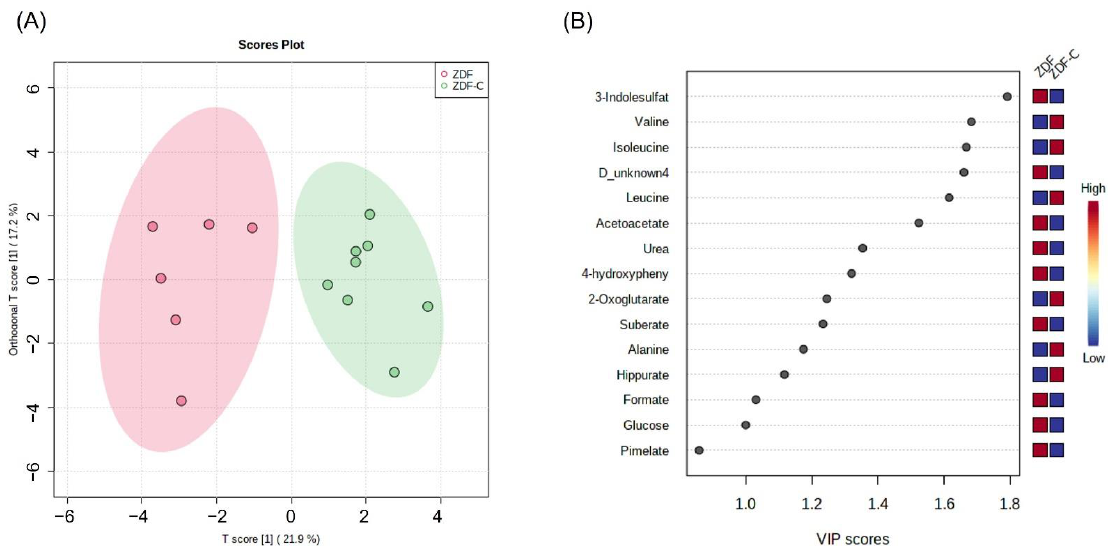
Figure 2. ( A ) Orthogonal partial least squares discriminant analysis (OPLS-DA) score plots from urine samples of diabetic (ZDF) and cocoa-supplemented diabetic (ZDF-C) rats at 20 weeks of life. ( B ) VIP values derived from OPLS-DA. The blue and red boxes on the right indicate whether the mean metabolite abundance is increased (red) or decreased (blue) in ZDF-C vs. ZDF. For these 14 metabolites, we further assessed their differential urine concentration between groups, yielding eight metabolites (valine, leucine, isoleucine, acetoacetate, urea, hippurate, 3- indolelsulfate, and D_unknow4) that were significantly modified by the cocoa intake (Figure 3).